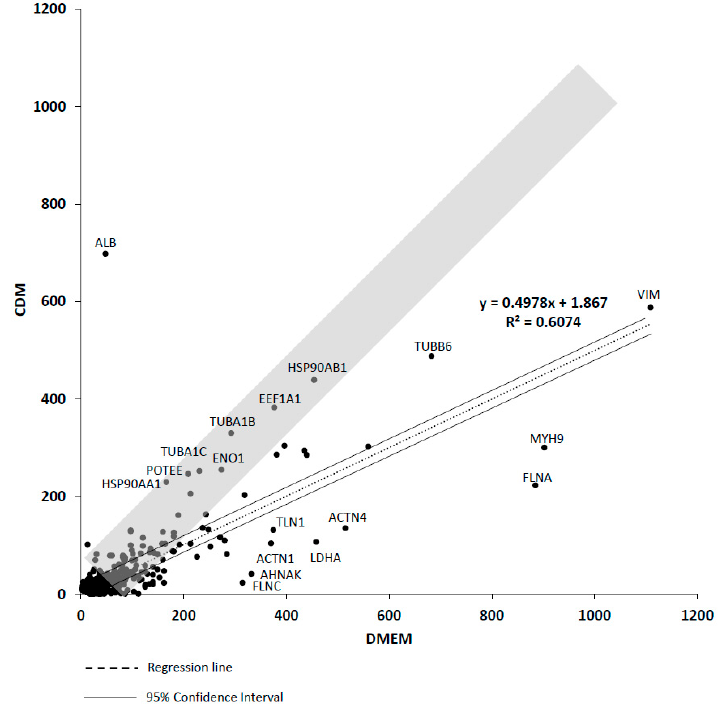
Figure 3. A scatter plot of the quantitative value (normalized emPAI) per housekeeping gene. A scatter plot showing correlation (R 2 = 0.6074; gray band indicates “R 2 = 1”) between the quantitative value of the CDM hADSCs and DMEM hADSCs ( n = 1139). The dotted line is the regression line. The two lines indicate the 95% confidence interval. Each dot shows the abbreviated name of the protein. n = 1.